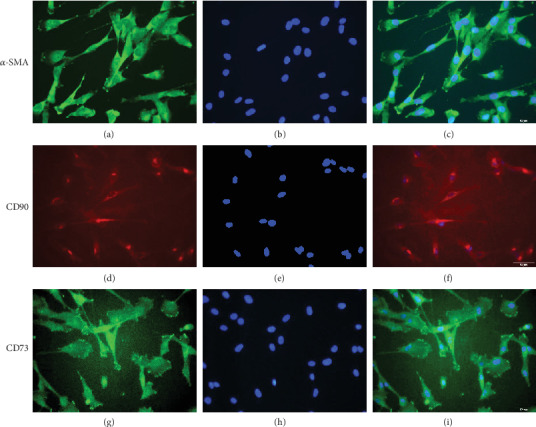
Marker protein expression in hUCB-MSCs. hUCB-MSCs from the normal group (n = 20) were stained for α-SMA (a, c), CD90 (d, f), and CD73 (g, i). Protein expression is indicated by green and red fluorescence, and nuclei are indicated by DAPI staining (blue; b, e, h).